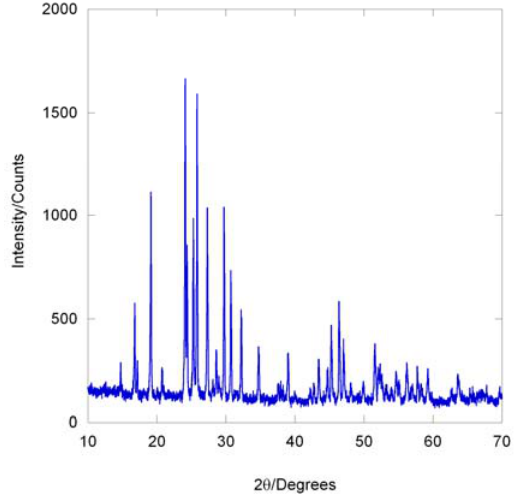
Figure 4. X-ray diffraction pattern of single phase Pba2-Y at 530 °C for 2